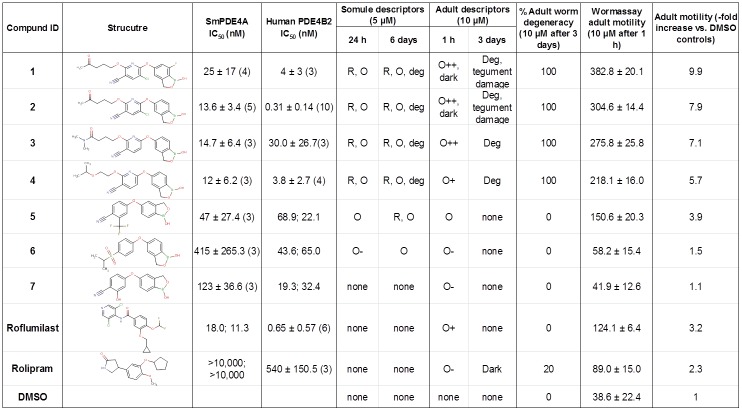
Association between inhibition of PDE4 and activity against the parasite for benzoxaborole and catechol inhibitors.Assays to determine IC50 values were performed in duplicate with the total number of assays performed indicated in parentheses: at a minimum, data from two assays are shown. Descriptions of phenotypes observed (descriptors): R = rounded; O = overactive (and perceived degrees thereof using plus and minus symbols); deg = degeneration; tegument damage = damage to the surface of the worms, dark = worms are darkened; none = no effects observed. Wormassay [102] is a digital camera based assay that detects adult worm-induced changes in the occupation and vacancy of pixels between frames (outputted as an average ± S.D.).